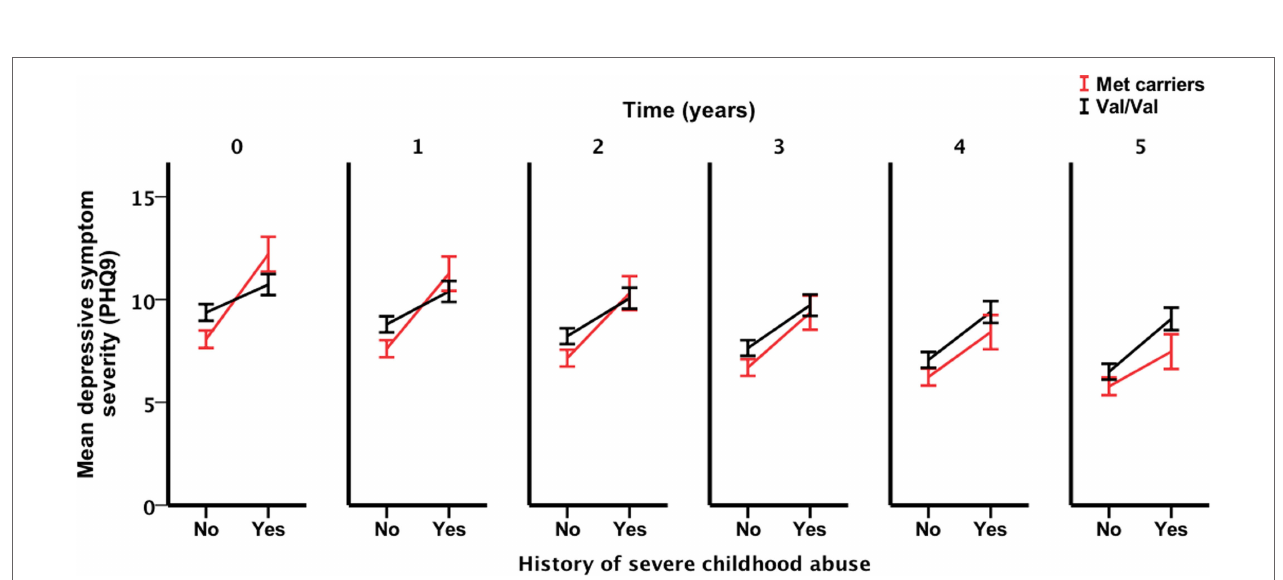
FigUre 2 | interaction effect of severe childhood abuse and BDNF Val66Met genotype on 5-year depressive symptom trajectories . Baseline represented by time point 0, annual assessment thereafter. Points and associated SE bars represent predicted values based on the final covariate-adjusted model. PHQ-9 = Primary Care Evaluation of Mental Disorders Patient Health